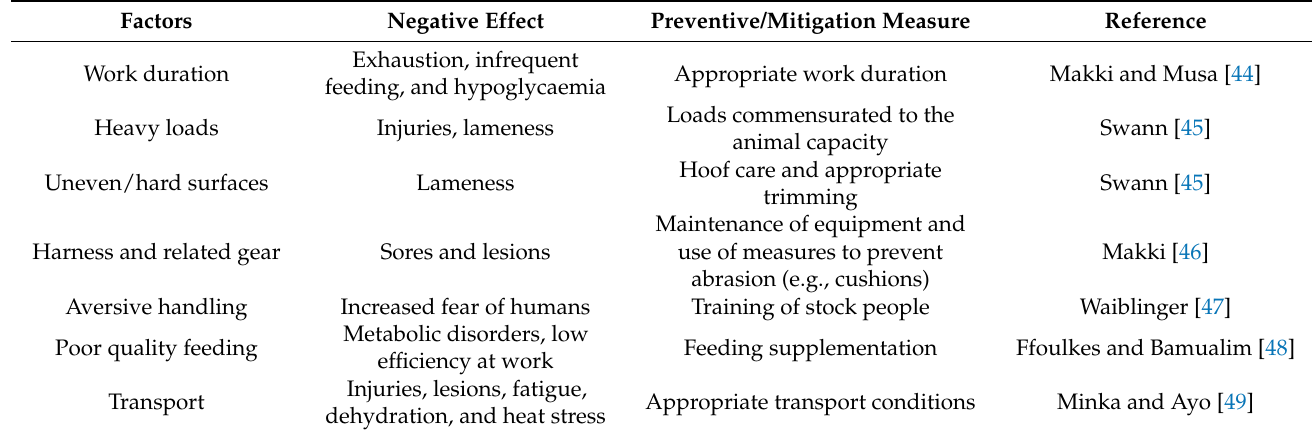
Table 1. Main factors potentially impairing draught animal